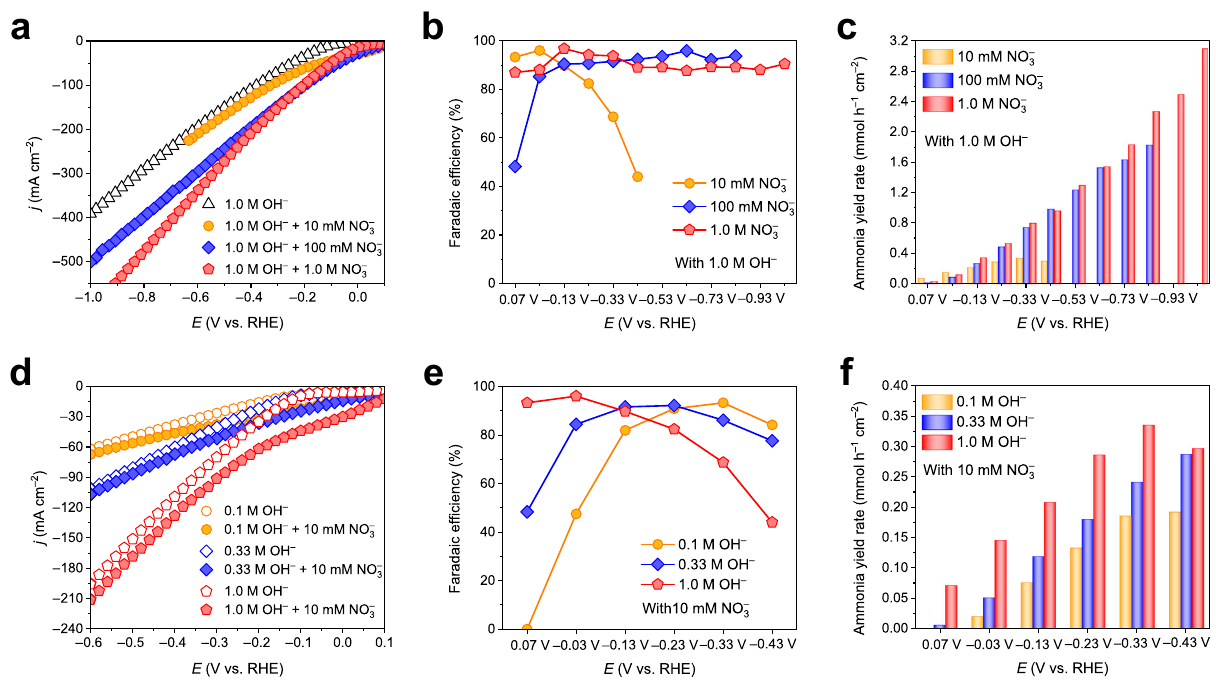
– . d LSV curves of CoP-CNS in different c OH – with and without 10mM NO c NO 3 e NH 3 FEs and f corresponding NH 3 yield rates of CoP-CNS at each given potential from 0.07 to – 0.43V vs. RHE in 10mM NO 3 – with different c OH – . Source data are provided as a Source Data fi